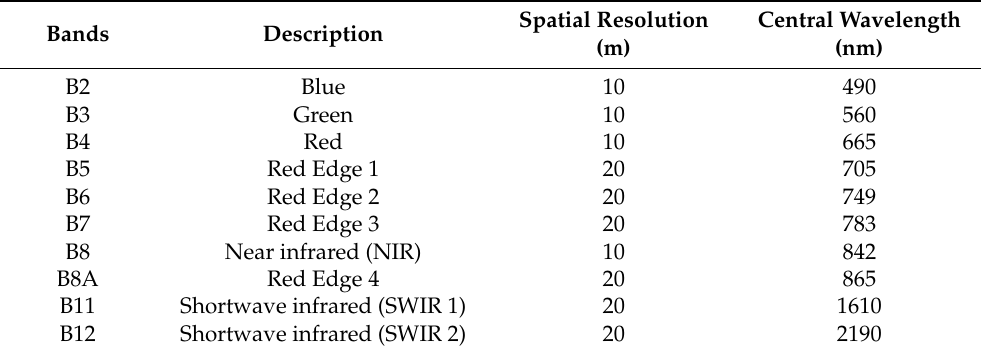
Table 1. Characteristics of Sentinel-2 bands used in this study.